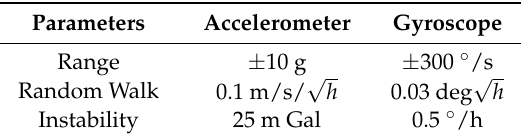
Table 1. IMU Table 1. IMU specifications.